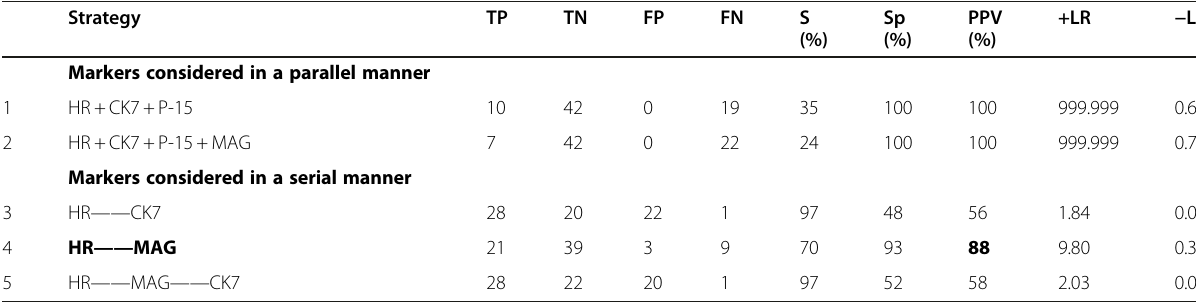
Table 3 Immunohistochemical strategies, statistical